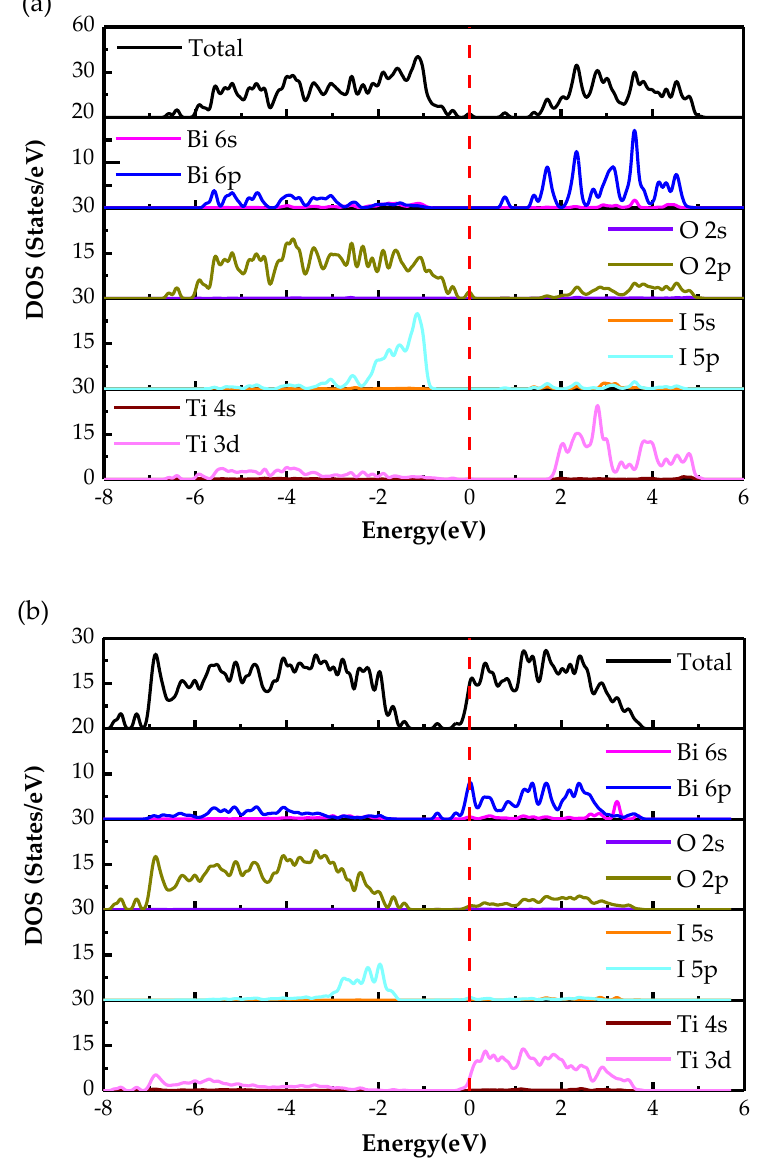
Figure 4. The total and partial density of states of ( a ) 1I-BiOI / TiO 2 , ( b ) BiO-BiOI / TiO 2 heterojunctions. Red dashed line represents the Fermi level.